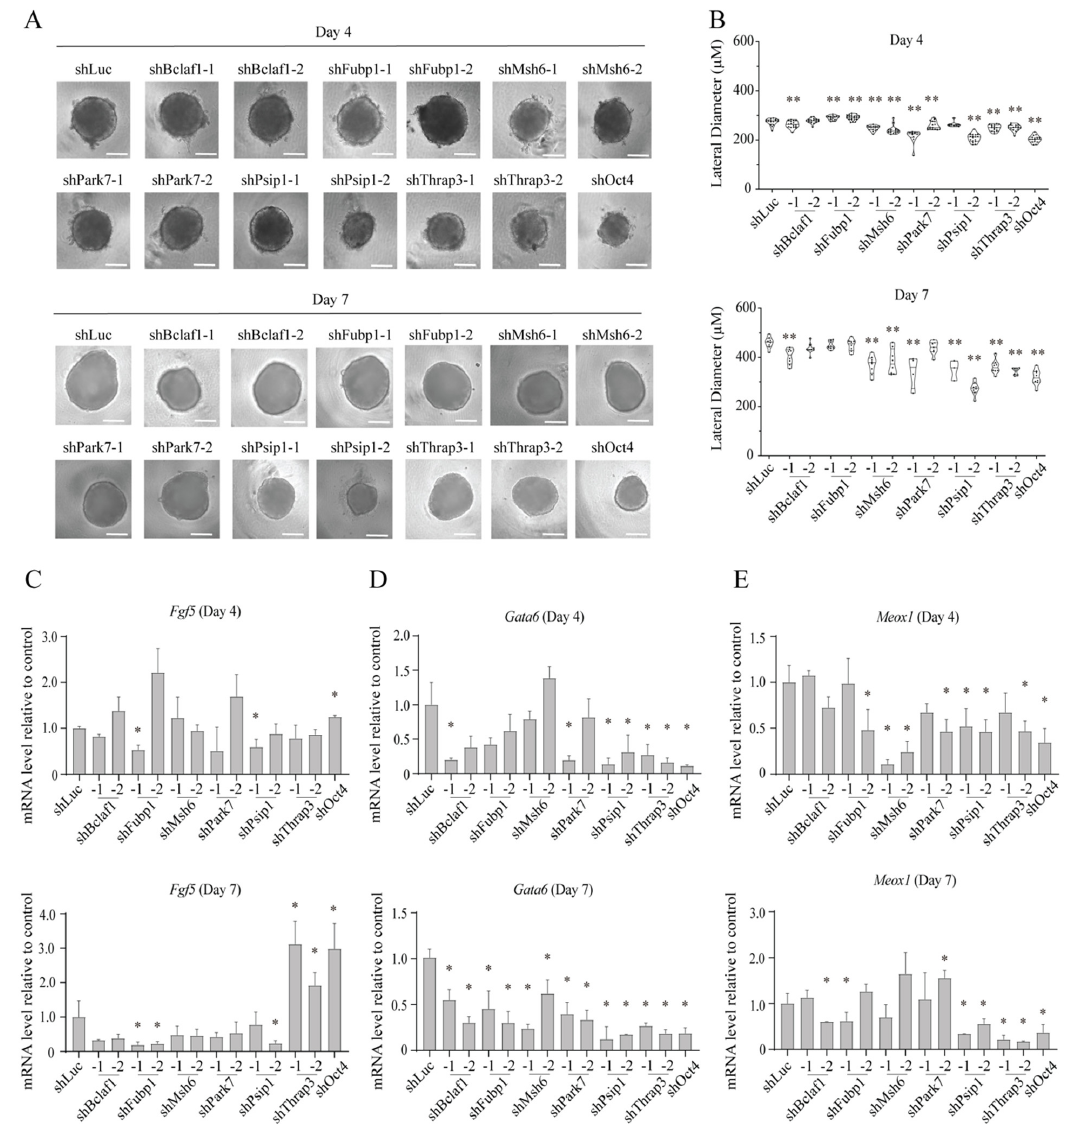
Figure 5. Effect of knockdown of identified proteins on differentiation of mESCs. ( A ) Bright-field images of EBs. Representative image of EB from EB5/ReKO cells treated with indicated shRNA and cultured in EB differentiation medium were taken at the indicated date. Scale bars, 150 µm. ( B ) Size of EBs. Lateral diameters of EBs from EB5/ReKO cells prepared as ( A ) were measured 4 days (upper) or 7 days (lower) after sorting. Data represent the mean ± SEM of 16 (Day 4) or 8 (Day 7) colonies. ** p < 0.01 versus EB5/ReKO cells treated with control shRNA (shLuc). ( C – E ) mRNA level of lineage marker genes. Fgf5 ( C ), Gata6 ( D ), or Meox1 ( E ) mRNA levels in the EB from EB5/ReKO cells prepared as ( A ) were determined 4 days (upper) or 7 days (lower) after cell sorting. Data represent the mean ± SEM of three independent experiments. * p < 0.05 versus EB5/ReKO cells treated with control shRNA (shLuc).